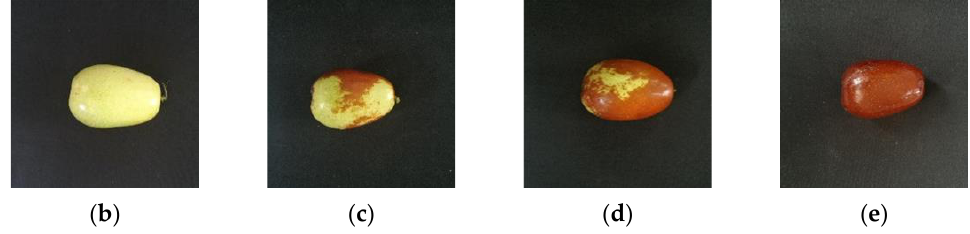
Figure 1. ‘ Hupingzao ’ jujubes at different maturity levels. ( a ) Immaturity; ( b ) white maturity; ( c ) early-red maturity; ( d ) half-red maturity; ( e ) full maturity.